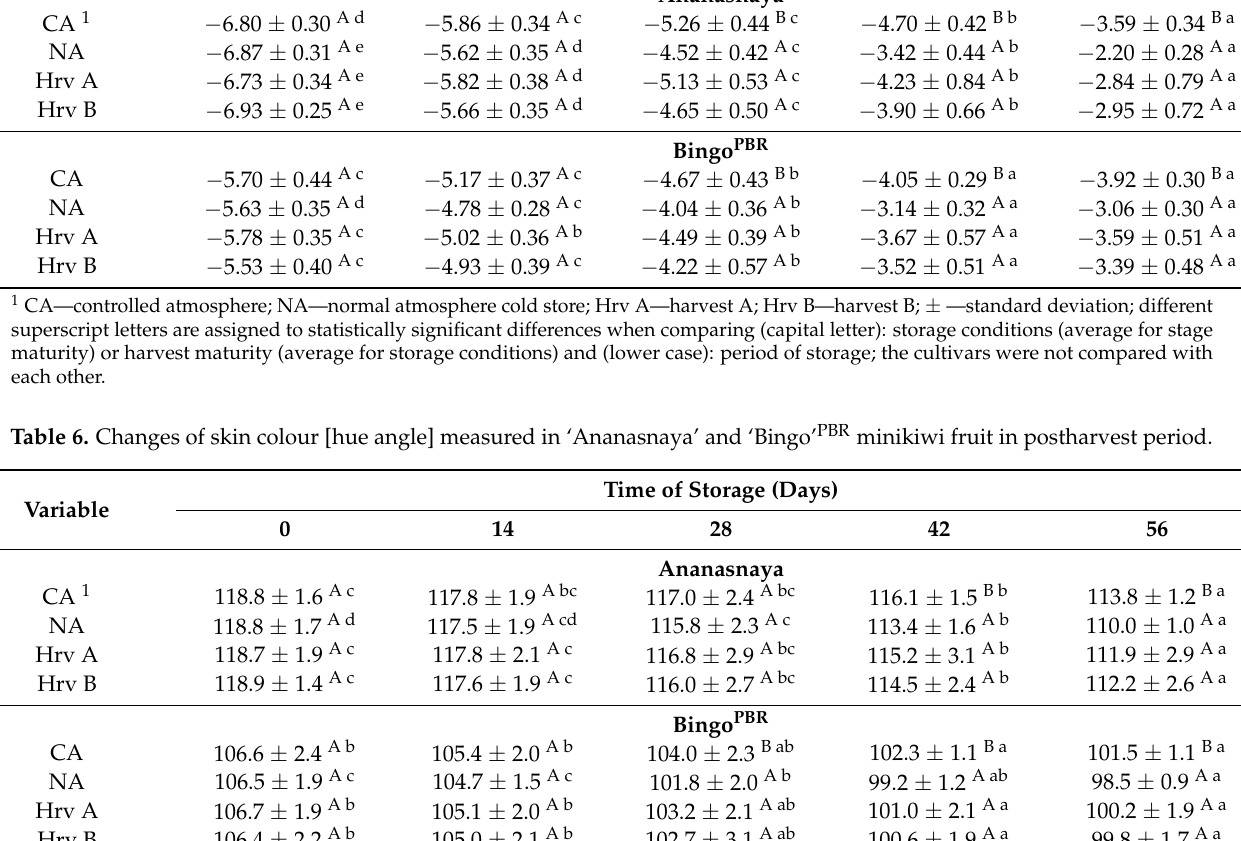
Table 5. Changes of skin colour [parameter ‘a’] measured in ‘Ananasnaya’ and ‘Bingo’ PBR minikiwi in postharvest period. Variable